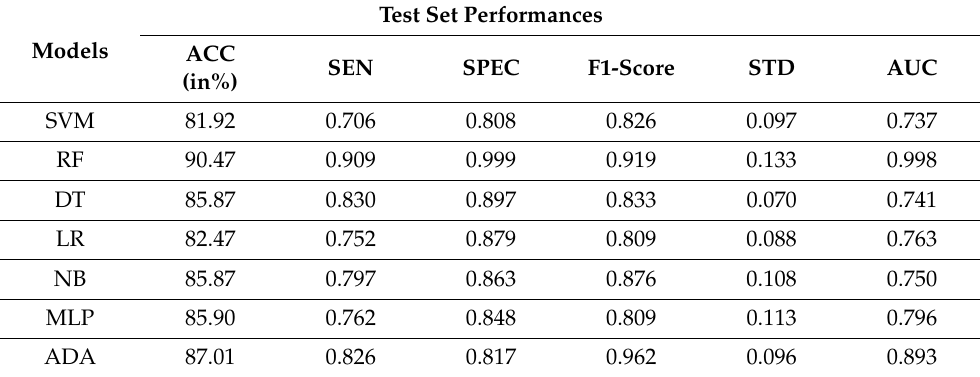
Table 8. Performance with balanced data set using five-fold CV.